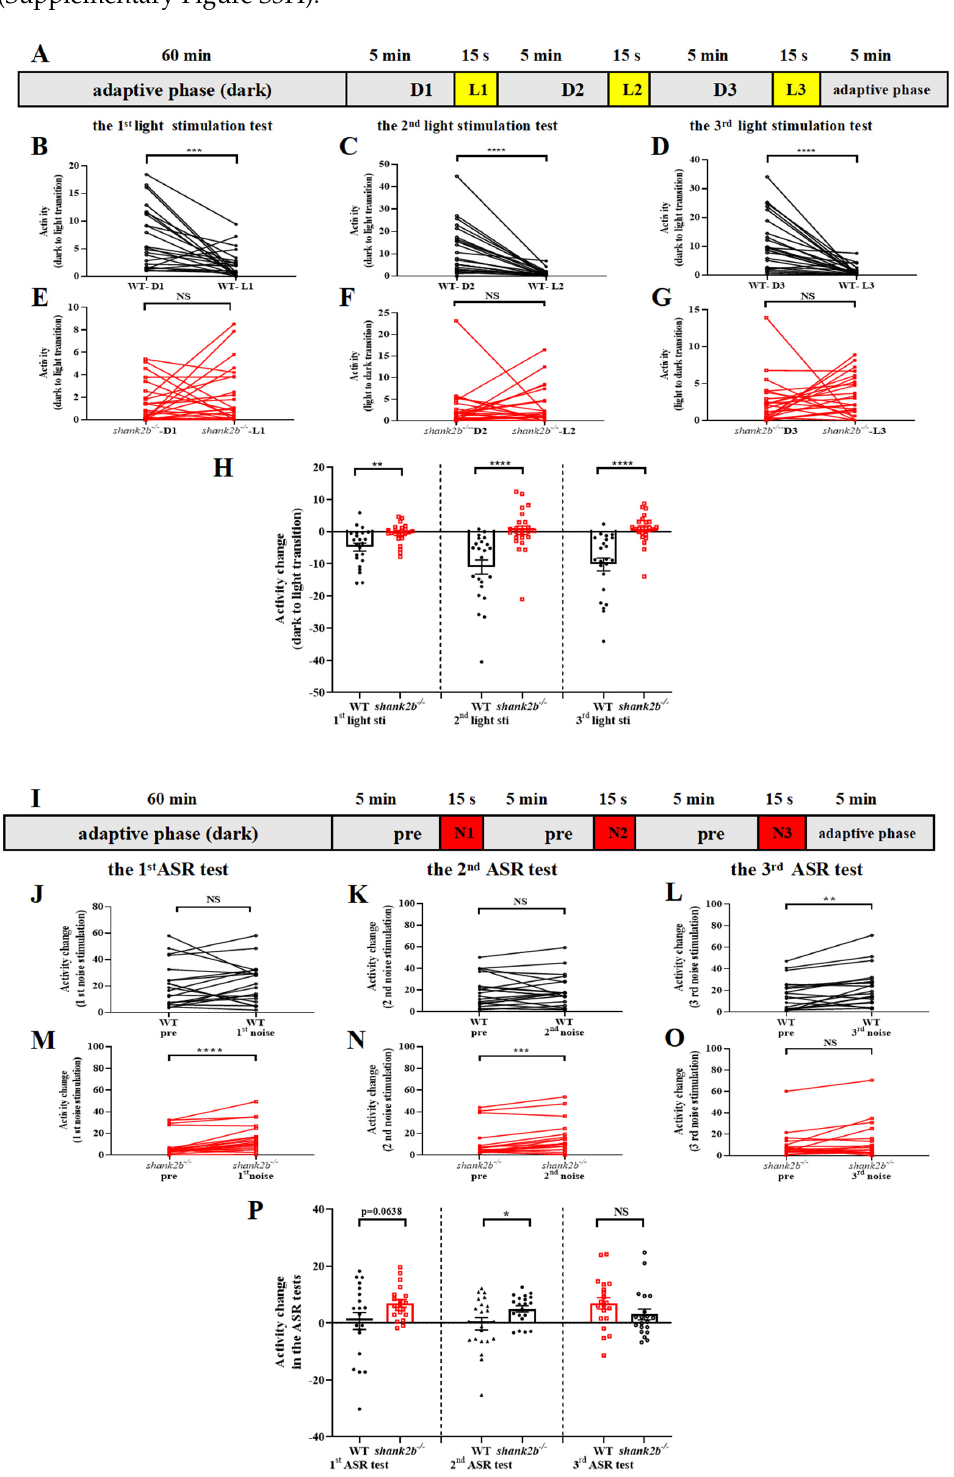
Figure 3. Abnormal response to visual and auditory stimuli in shank2b larva. ( A ) Scheme and behavioral setup applied for locomotor activity tracking in VMR response to light stimulation of zebrafish larvae at 13 dpf. The experiment consisted of a 60-min adaptation period under continu ‐ ous dark and a 20 min 45 s testing period consisting of three VMR. The VMR experiment consisted of 5 min of conditioning to darkness and 15 s of stimulation by a sudden light stimulus. ( B – D ) WT